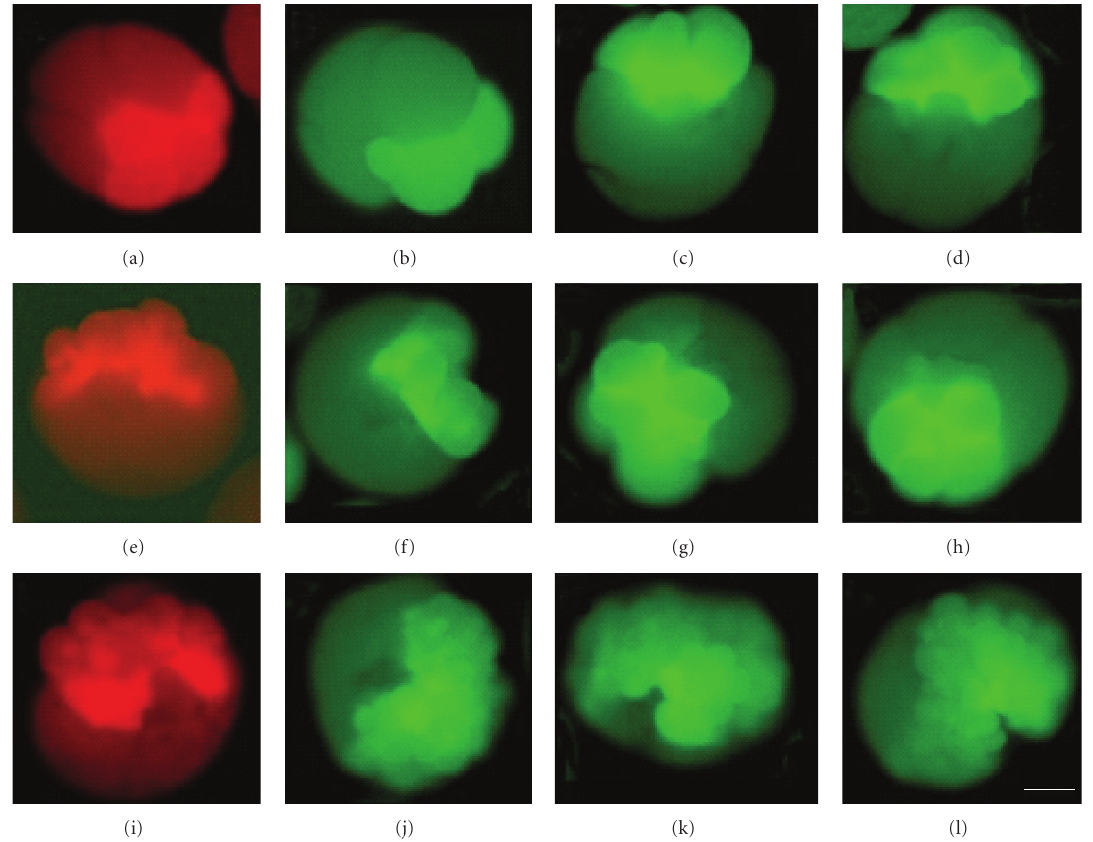
Figure 6: Time course of cell divisions leading to proliferated cell clusters following Tpr antisense oligonucleotide microinjections into the D macromere. (a) Normal embryo ∼ 6 hours after microinjection with sense oligonucleotide TprC (co-injected with RDA; red). (b)– (d) Representative atypical cleavages ∼ 6 hours after microinjection with antisense oligonucleotide TprB (co-injected with FDA; green). (e) Normal embryo ∼ 12 hours post-injection. (f)–(h) Antisense injected embryos ∼ 12 hours post-injection. (i) Normal embryo ∼ 24 hours